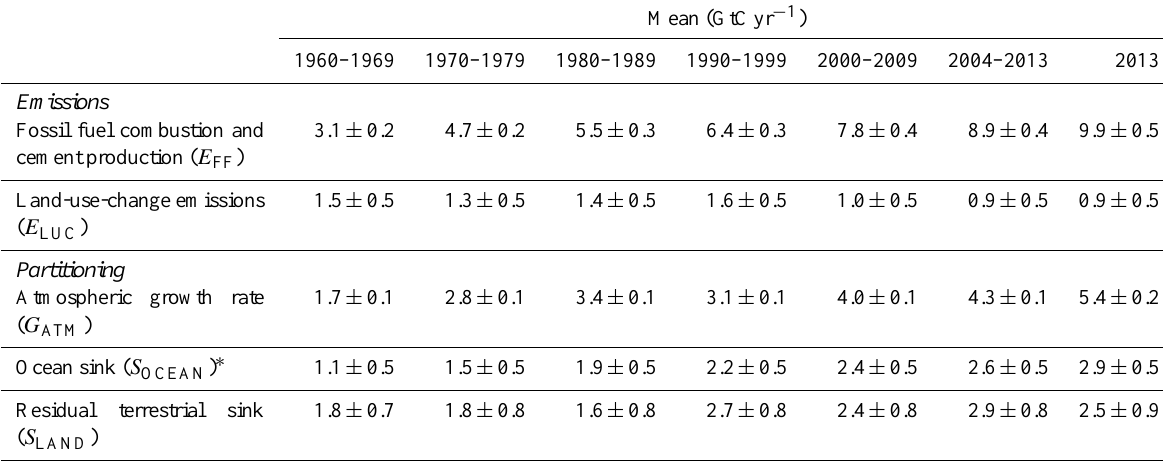
Table 8. Decadal mean in the five components of the anthropogenic CO 2 budget for the periods 1960–1969, 1970–1979, 1980–1989, 1990– 1999, 2000–2009, last decade, and last year available. All values are in GtCyr − 1 . All uncertainties are reported as ± 1 σ . A data set containing data for each year during 1959–2013 is available at http://cdiac.ornl.gov/GCP/carbonbudget/2014/. Please follow the terms of use and cite the original data sources as specified on the data